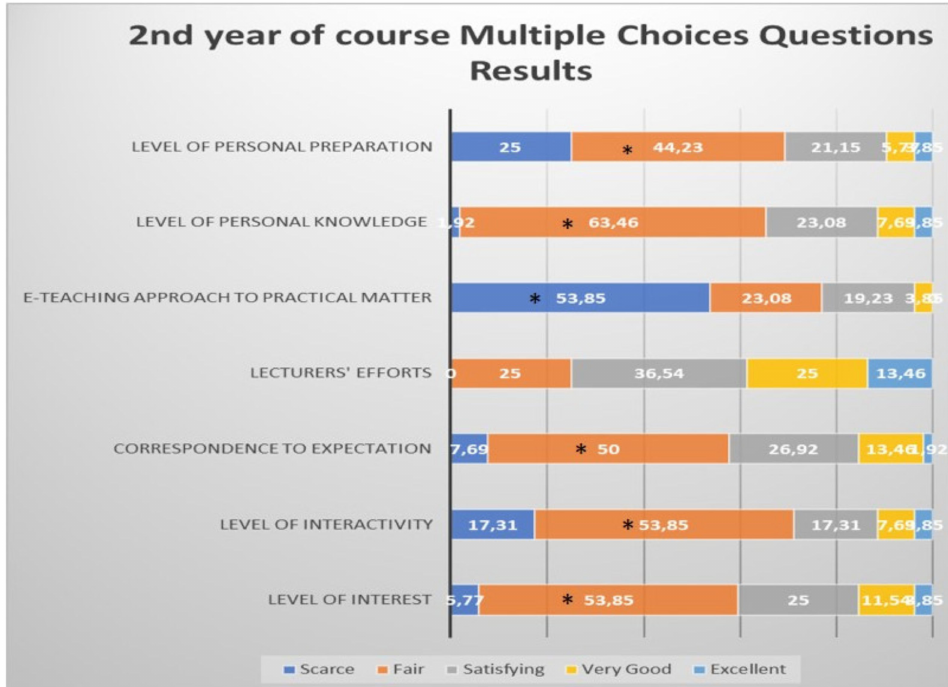
Figure 3. Questionnaire results for the second year student feedback to the e-learning and e-teaching approach. The numbers in the bars indicate the percentages of the answers received ( n = 301), * p < 0.05 (Pearson’s chi-squared tests). Although they defined the lecturers’ efforts mostly “satisfy- ing”, the difference did not reach statistical significance.